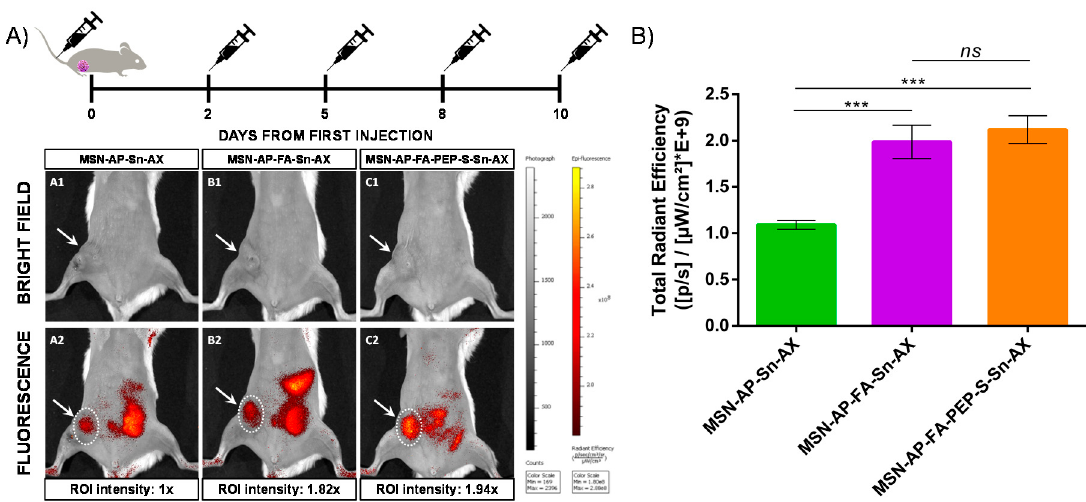
Figure 9. ( A ) In vivo fluorescence imaging of mice treated with di ff erent nanoparticles at endpoint: A: MSN-AP-Sn-AX (AX-1); B: MSN-AP-FA-Sn-AX (AX-2); C: MSN-AP-FA-PEP-S-Sn-AX (AX-3). Row 1